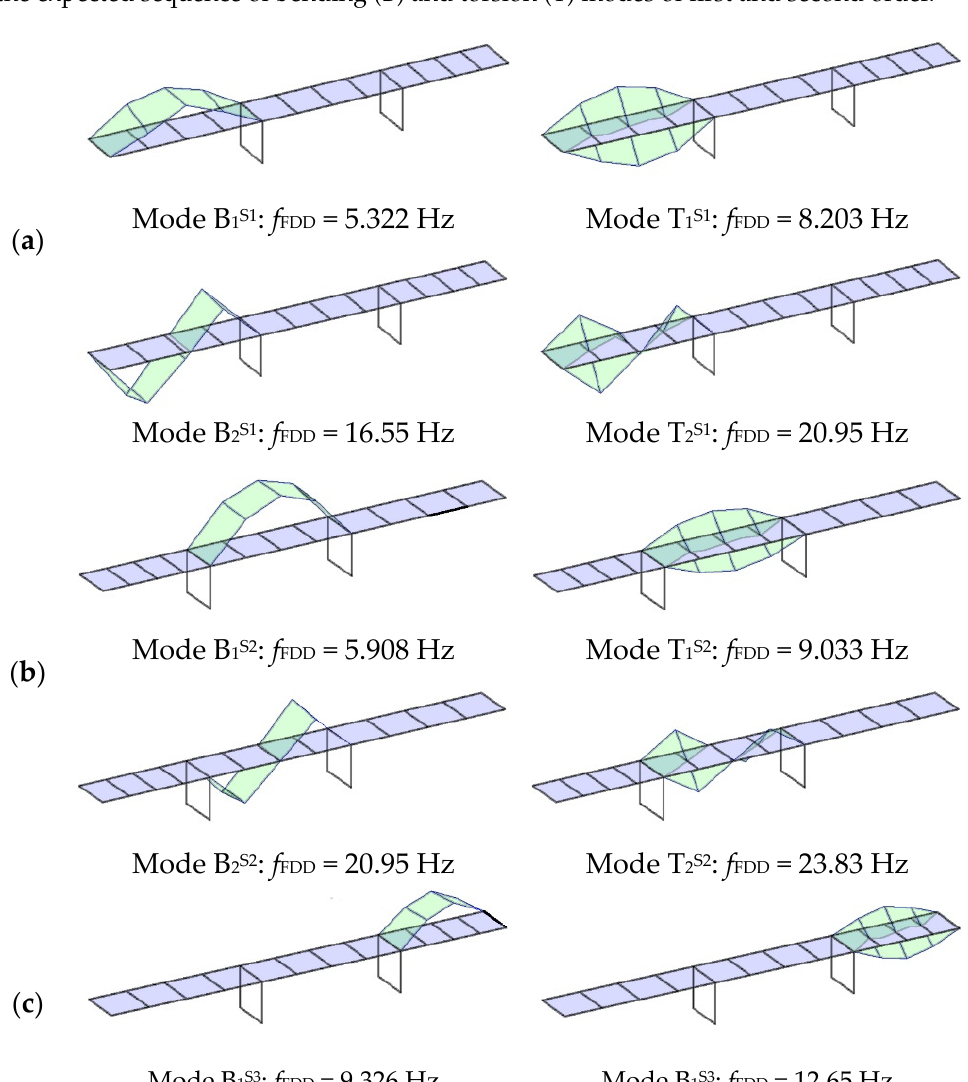
Figure 10. Vibration modes identified from the first AVT: ( a ) Span S1, ( b ) Span S2, and ( c ) Span S3.